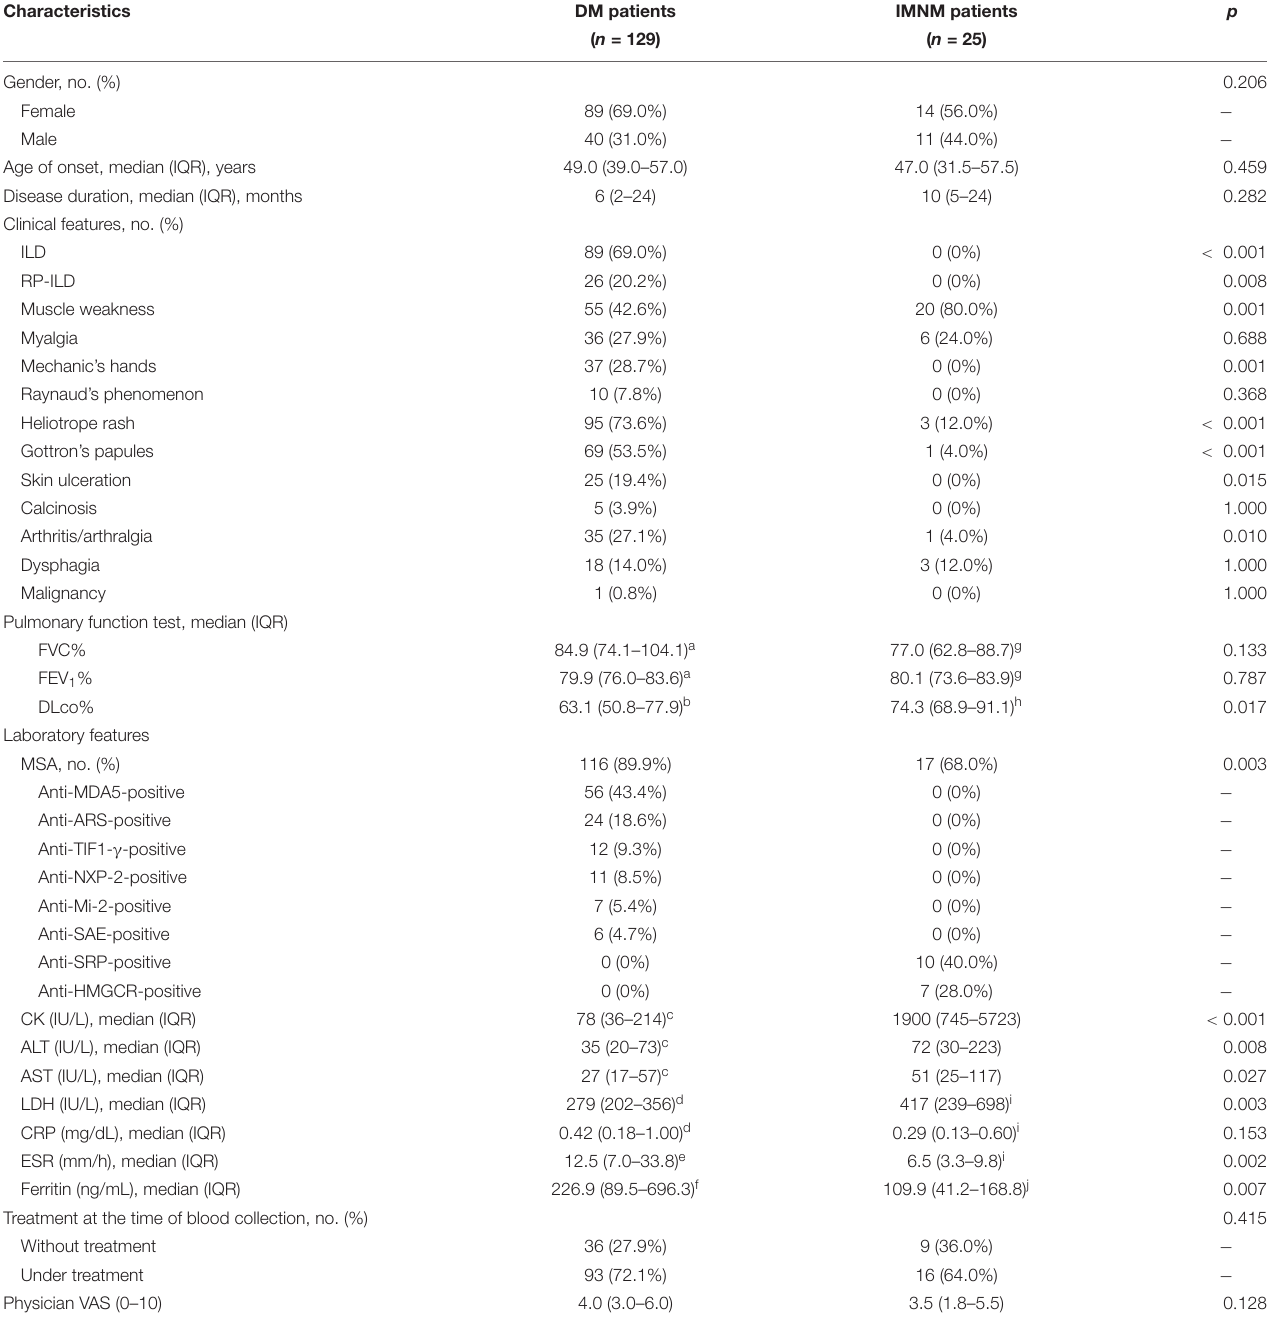
TABLE 1 | Baseline characteristics observed in DM patients and IMNM patients.